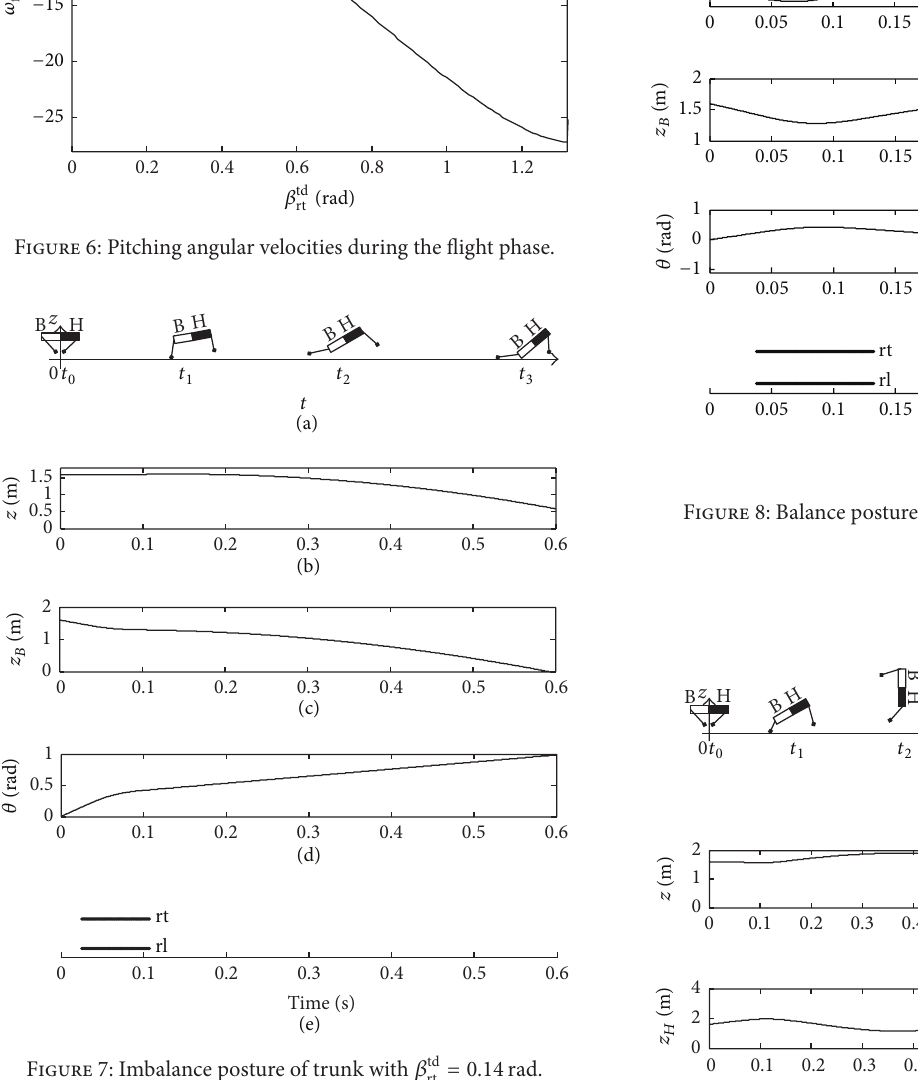
Figure 7: Imbalance posture of trunk with 𝛽 td rt = 0 . 14 rad.